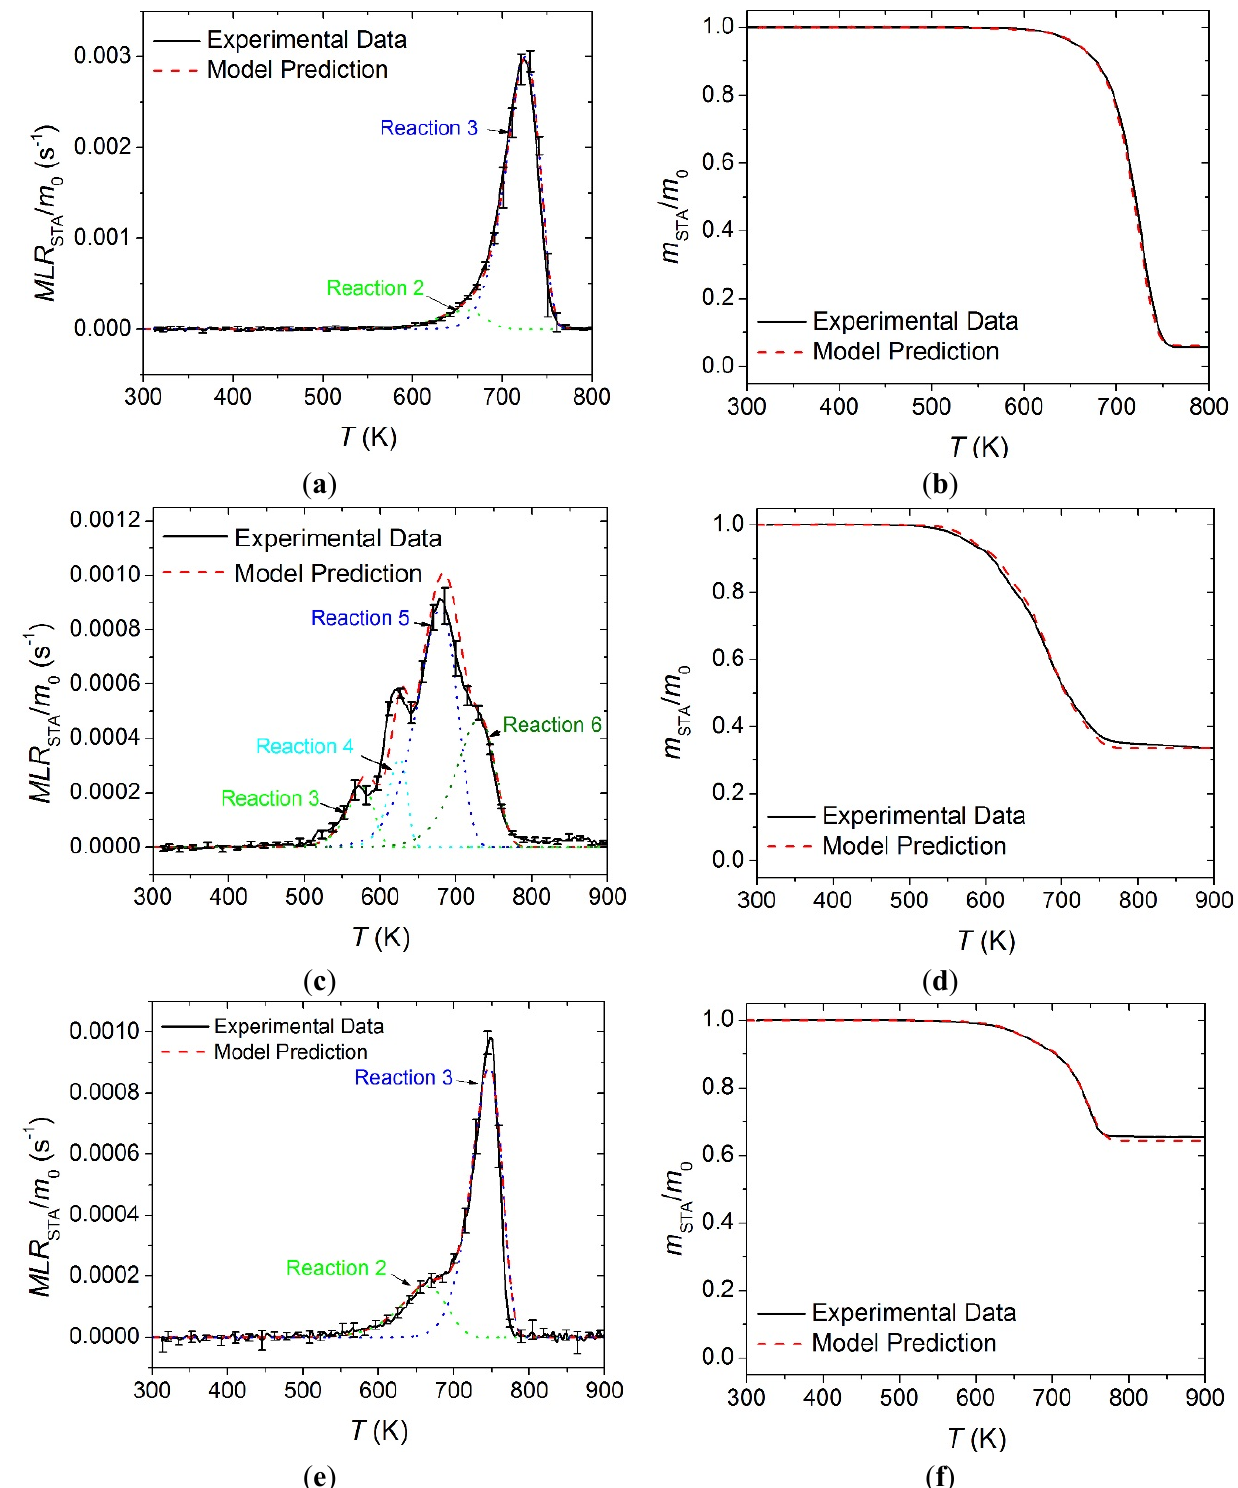
Figure 7. Normalized mass loss rate ( MLR ) and normalized mass data collected in STA experiments and model predicted curves for: ( a ) and ( b ) face yarn layer; ( c ) and ( d ) the middle layer; and ( e ) and ( f ) the base layer. Error bars indicate two standard deviations of the mean experimental data.